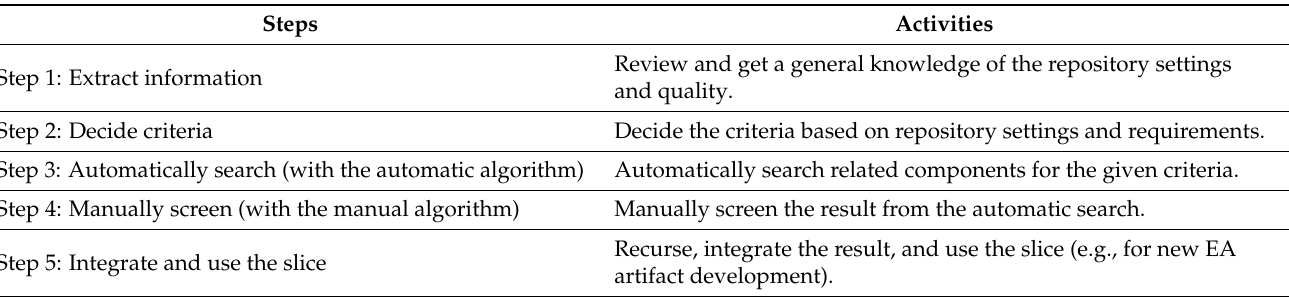
Table 1. The proposed method of EAS.